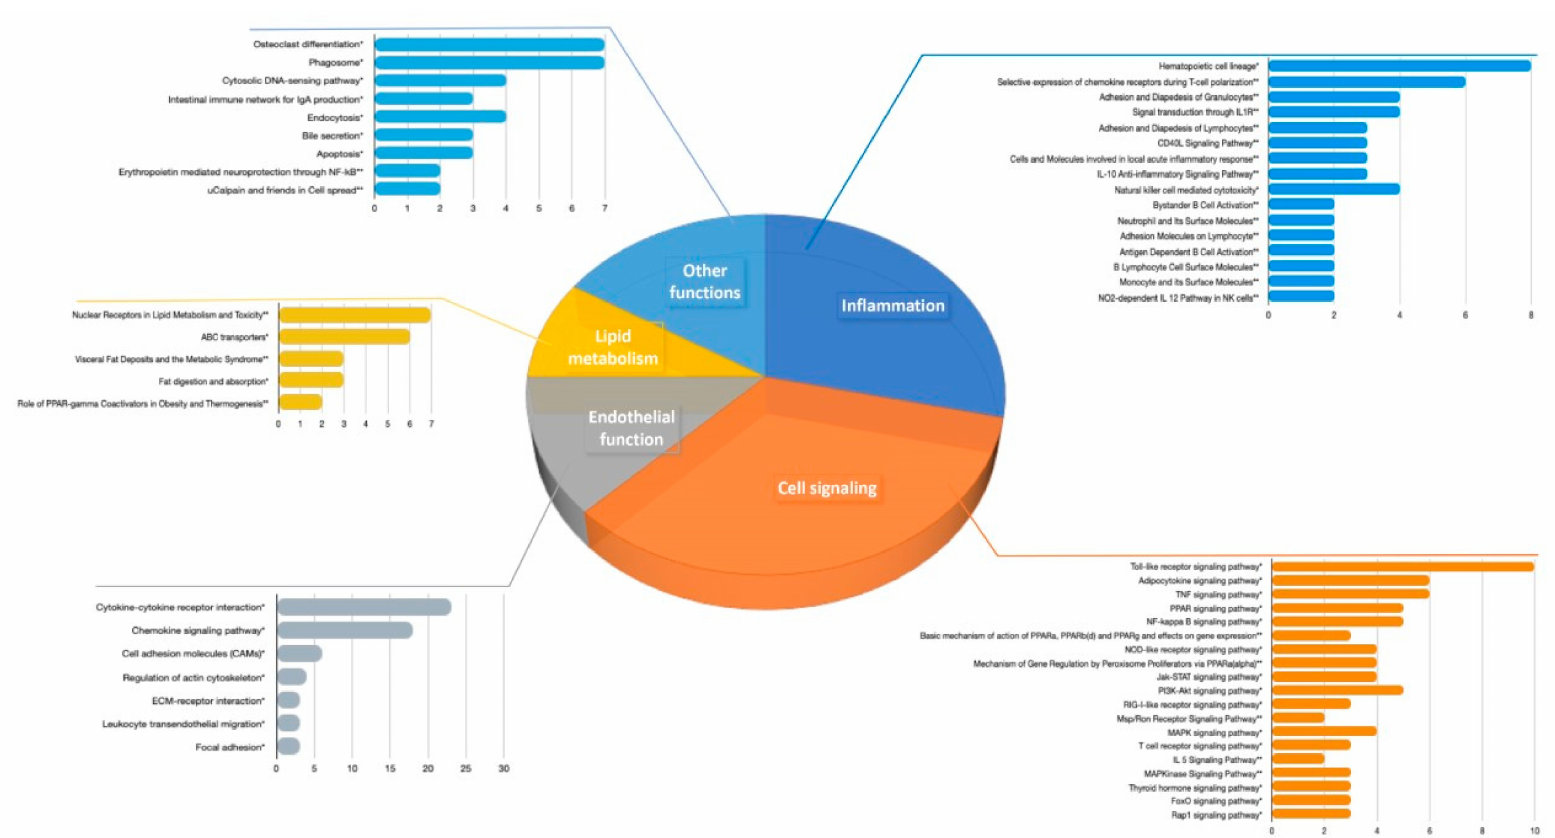
Figure 2. KEGG and top BioCarta pathways related to cellular processes, significantly associated with polyphenol modulated mRNA transcripts ( x -axis represents the number of hits, i.e., number of genes in the pathway that are extracted from the eligible papers; within each group, pathways are arranged according to their p -values, in ascending order). KEGG pathways are marked with *; BioCarta pathways are marked with